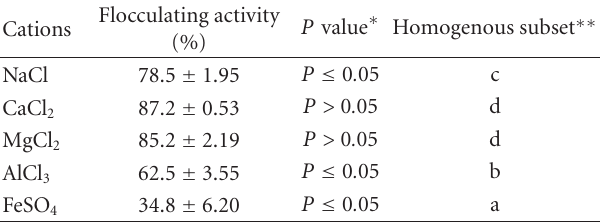
∗ The mean di ff erence between groups is significant at 0.05 level. ∗∗ Homogenous subset is in ascending manner from lowest to the highest mean value. Table 2: Statistical analysis for flocculating activity at di ff erent pH conditions.